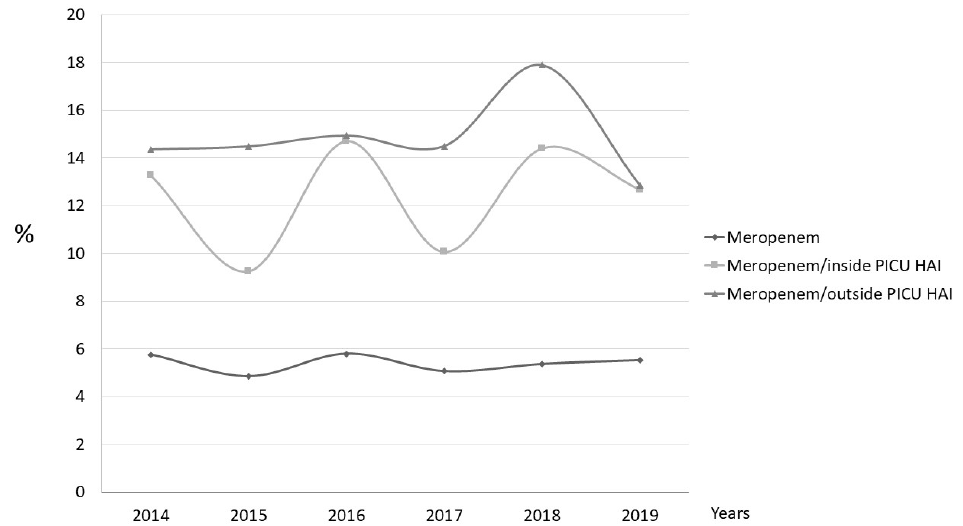
Figure 3. Evolution over time of the global use of meropenem (meropenem with respect to the global antibiotic indication) and the use of meropenem for suspected healthcare-associated infection (prescription of meropenem with respect to the indication of antibiotics for suspected healthcare-associated infection).